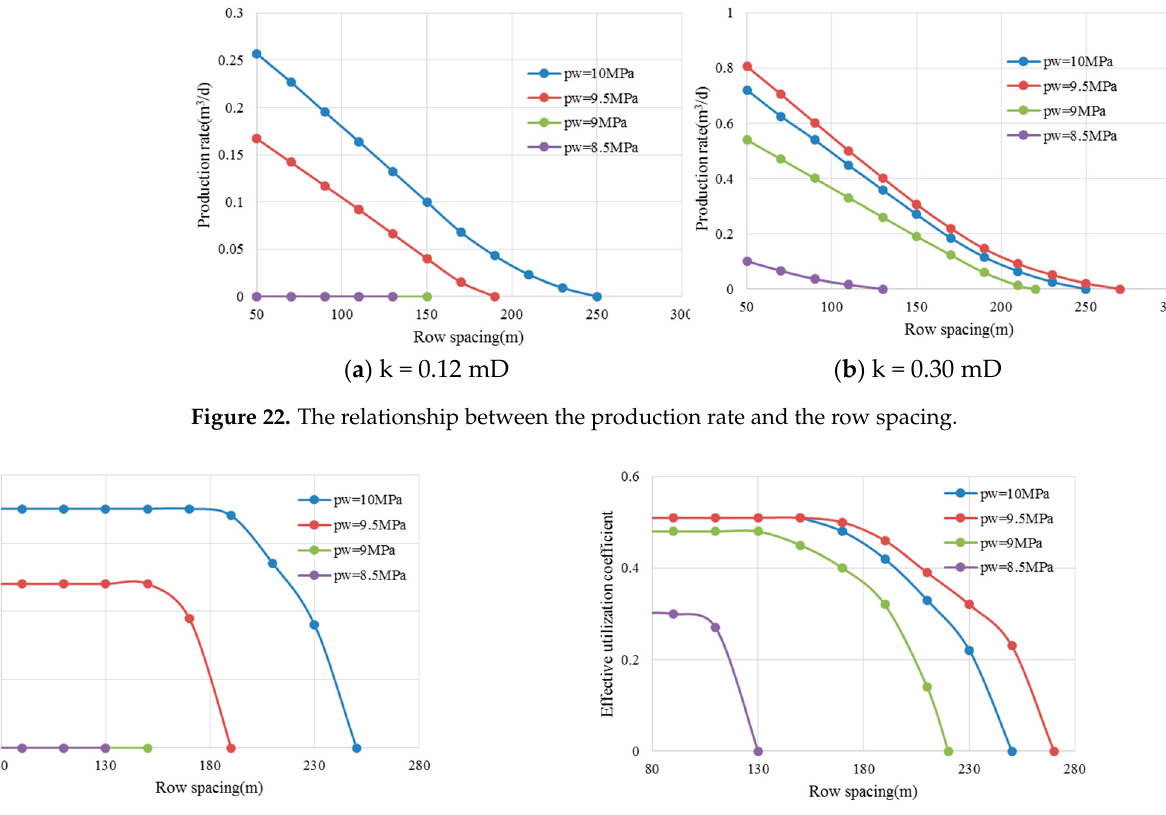
Figure 21. The relationship between the effective utilization coefficient and the well spacing after fracturing.